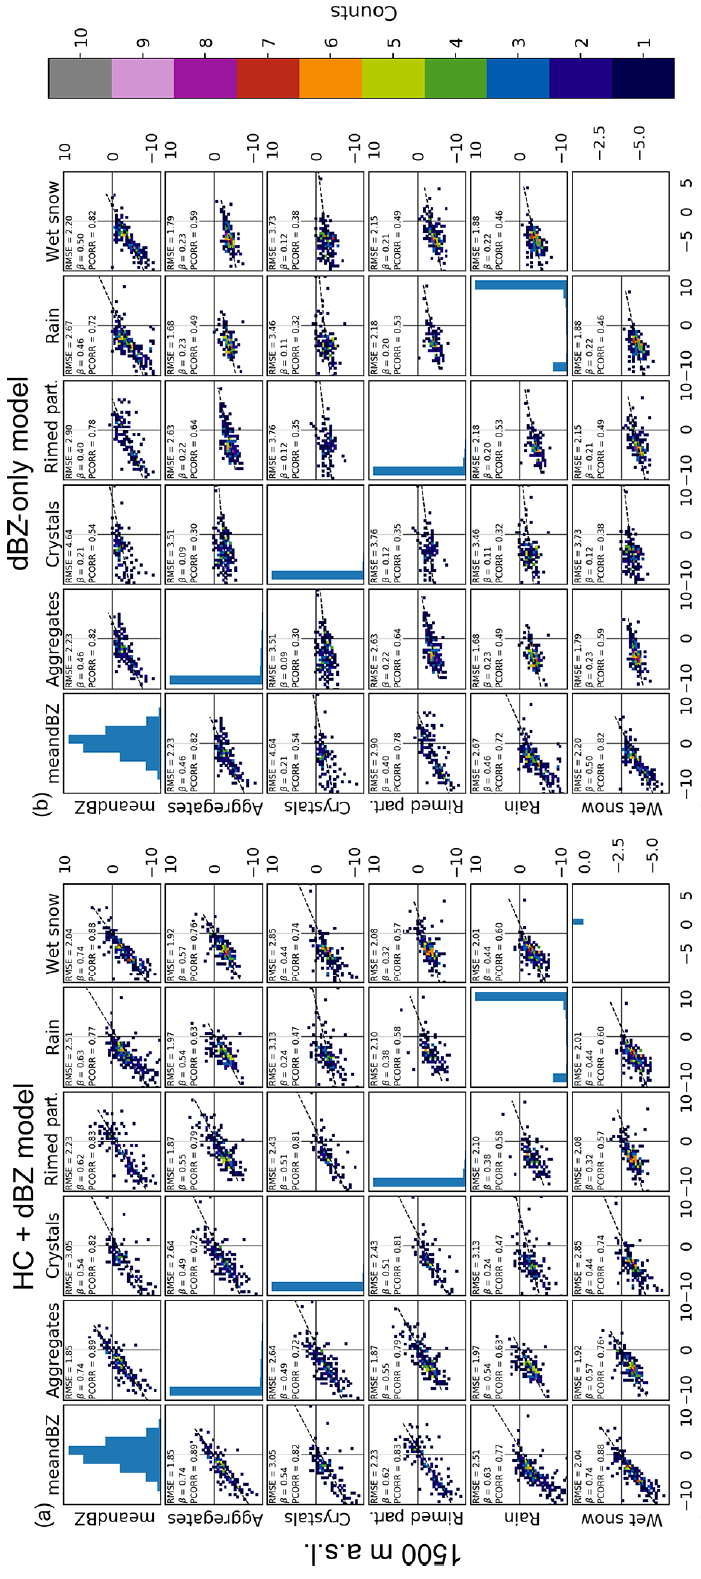
Figure 10. The 2-D matrices for observed ( x axes) and predicted ( y axes) GD for the HC + dBZ model (a) and dBZ-only model (b) trained from 1500ma.s.l. and data aloft. The number of points in each bin is indicated in